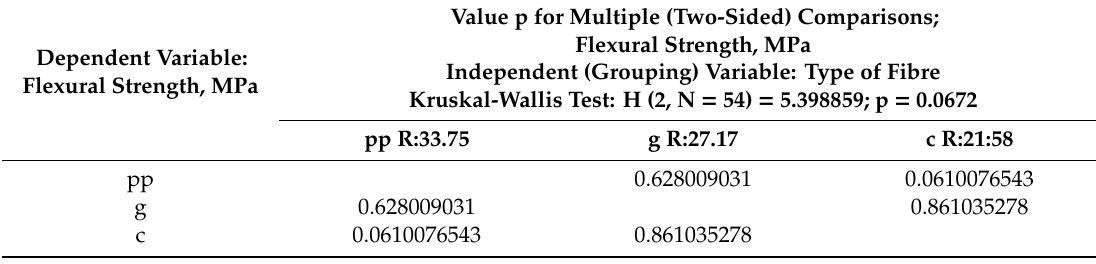
Table 6. Values p for two-sided comparisons.